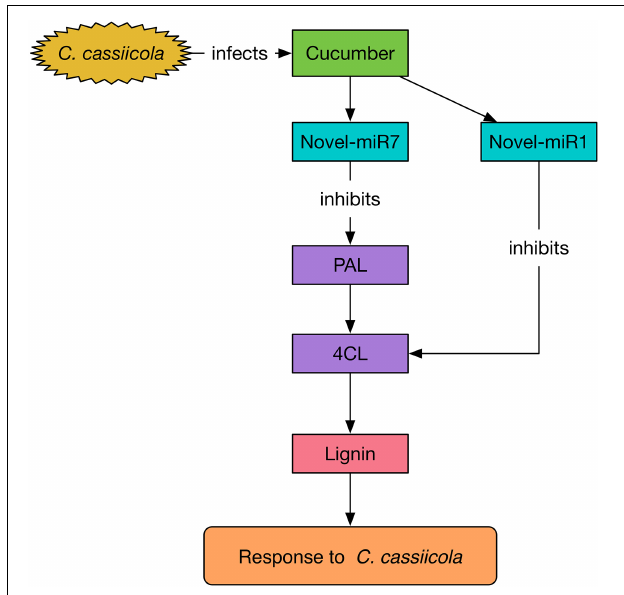
FIGURE 8 | Mechanism of Novel-miR1 and Novel-miR7 regulation network involved in the response to C. cassiicola